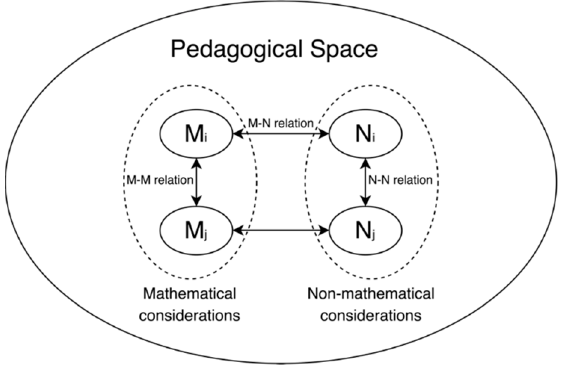
Figure 2. A conceptual framework for pedagogical flexibility (PF) in curriculum use.